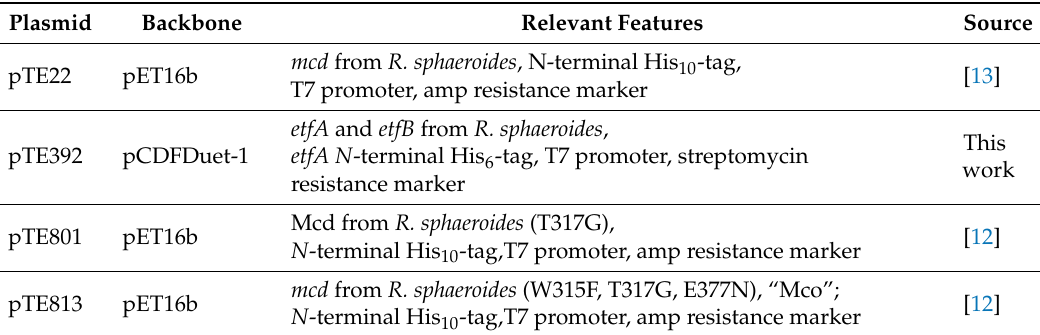
Table 1. Plasmids used in this study.